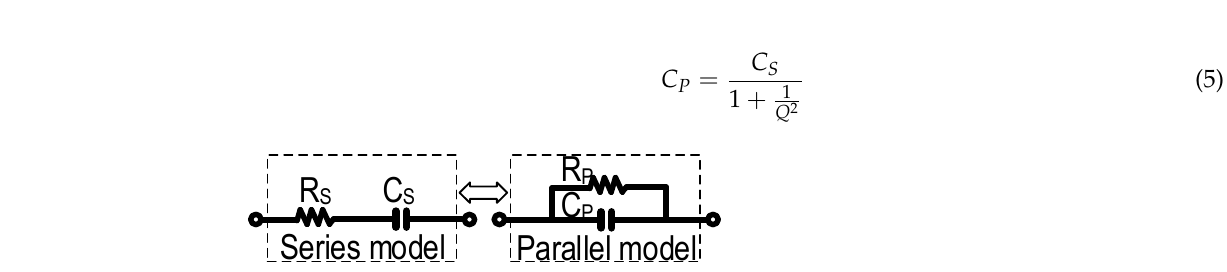
Figure 8. Four configurations of L-network: ( a ) Low pass CL for R S > R L , ( b ) High pass LC for R S > R L , ( c ) Low pass LC for R S < R L , ( d ) High pass CL for R S < R L .